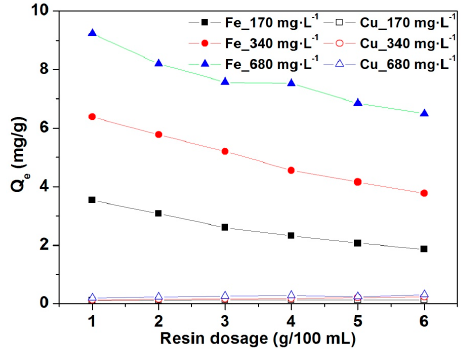
Figure 1. Iron and copper adsorption by Rexp-501 at various concentrations, 298 K.